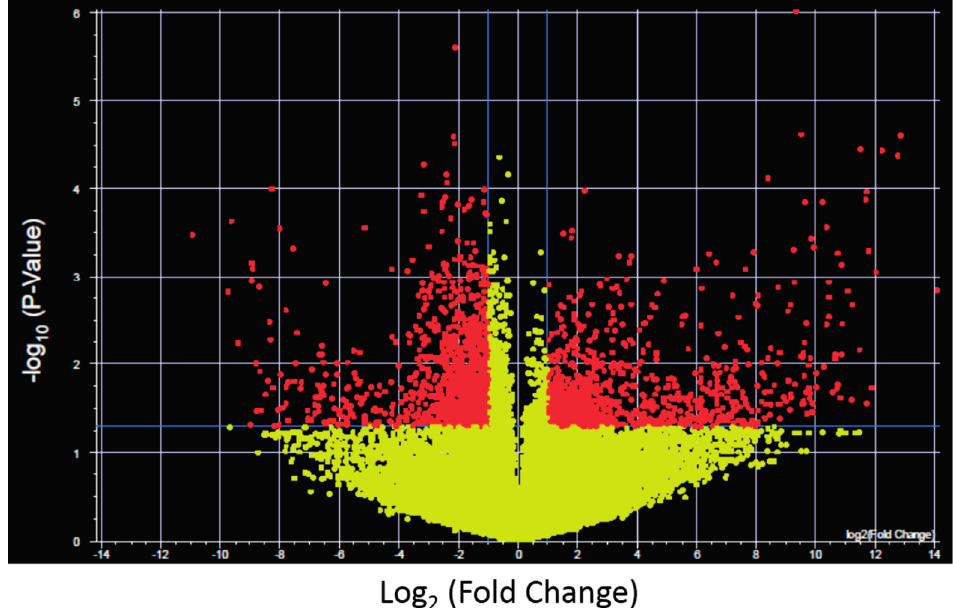
Figure 2. Example of a Volcano plot of altered transcript expression in control fibroblasts after UVC irradiation. − log 10 ( p -value) plotted against log 2 (Fold Change) for transcript expression in control fibroblasts before and after 2 J/m 2 UVC irradiation. Red spots represent 2575 transcripts with p < 0.05 and fold change >2, yellow spots represent transcipts that were not differentially expressed. Volcano plots were generated for each XP complementation group.